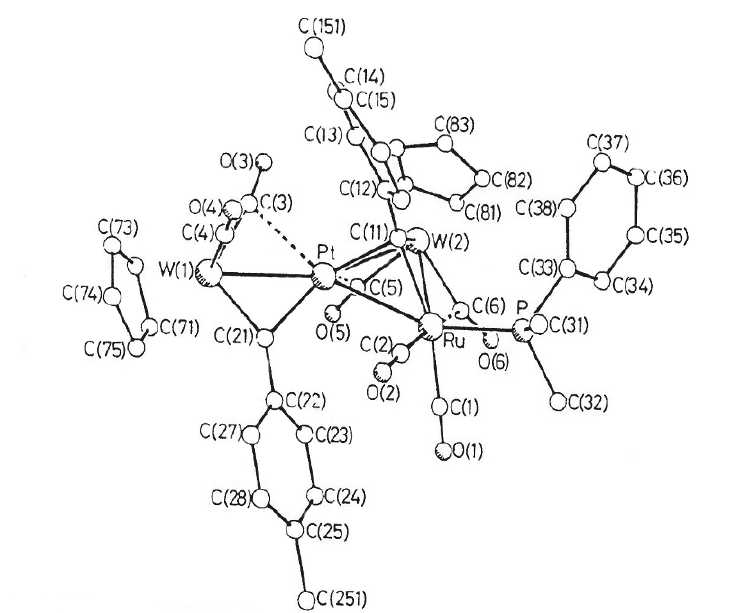
Figure 15. Structure of [W Table 4. Crystallographic and structural data for heterotetranuclear platinum clusters (Pt COMPOUND (colour)